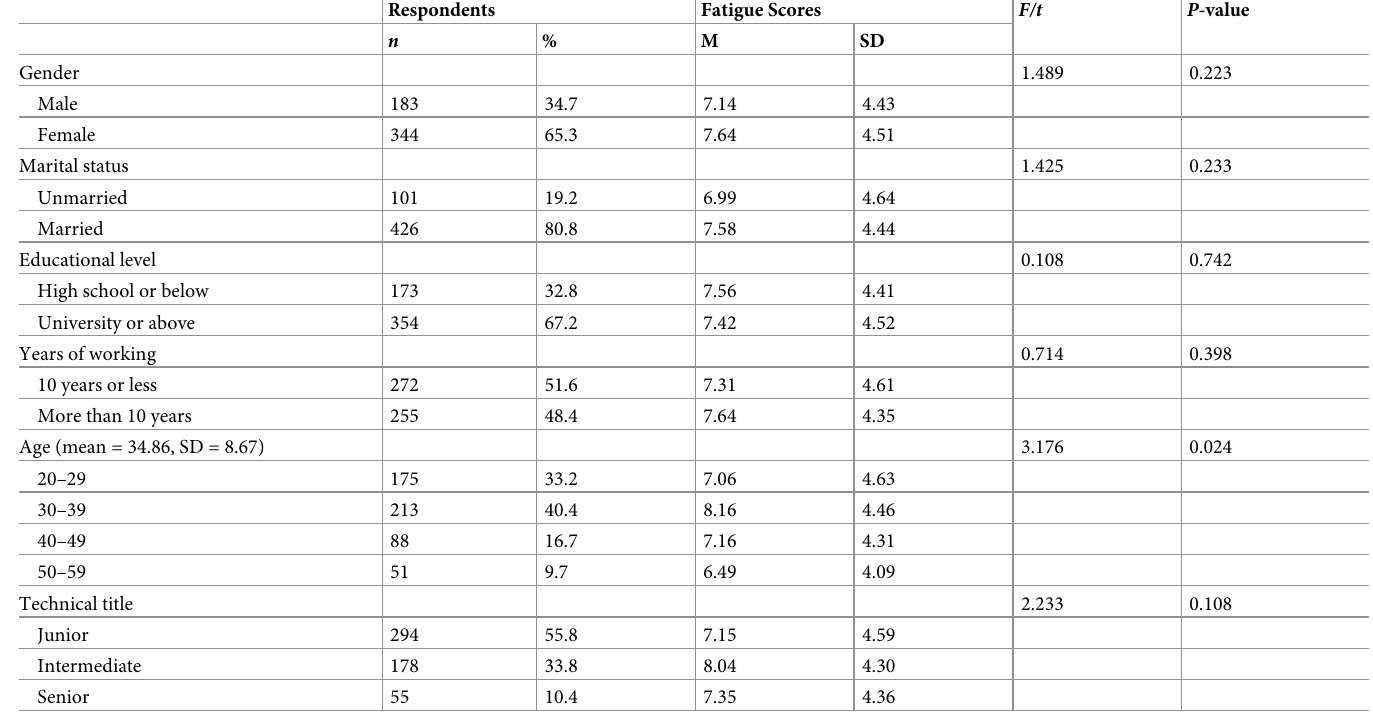
Table 1. Demographic and working characteristics of respondents ( N = 527) and group comparisons on